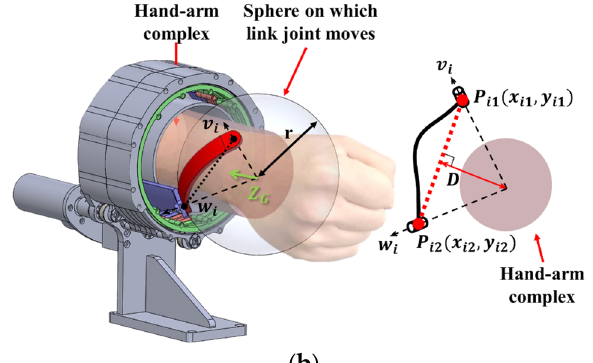
Figure 2. ( a ) An example situation of interference between the FC-WREI and forearm. ( b ) Description of D , which is a distance from a line between P i 1 and P i 2 to the centerline of the forearm. P i 1 ( x i 1 , y i 1 ) and P i 2 ( x i 2 , y i 2 ) are projections of the linkage joints on plane z = 0.